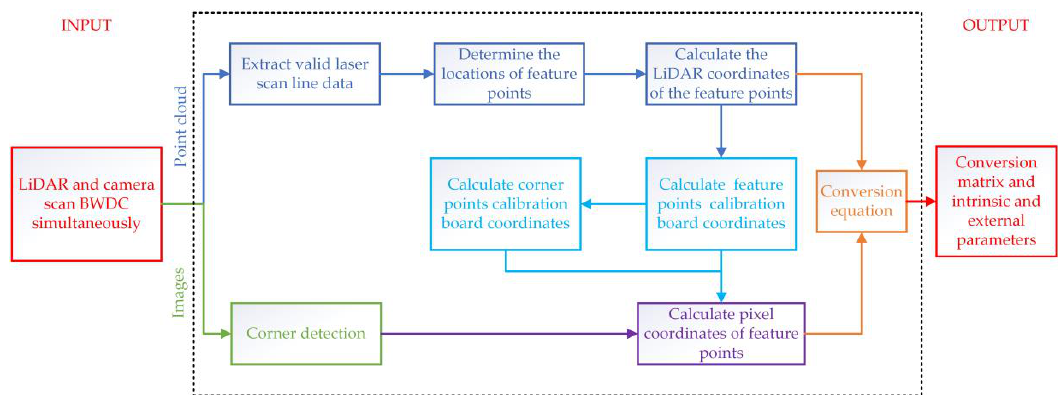
Figure 5. Calibration flowchart.